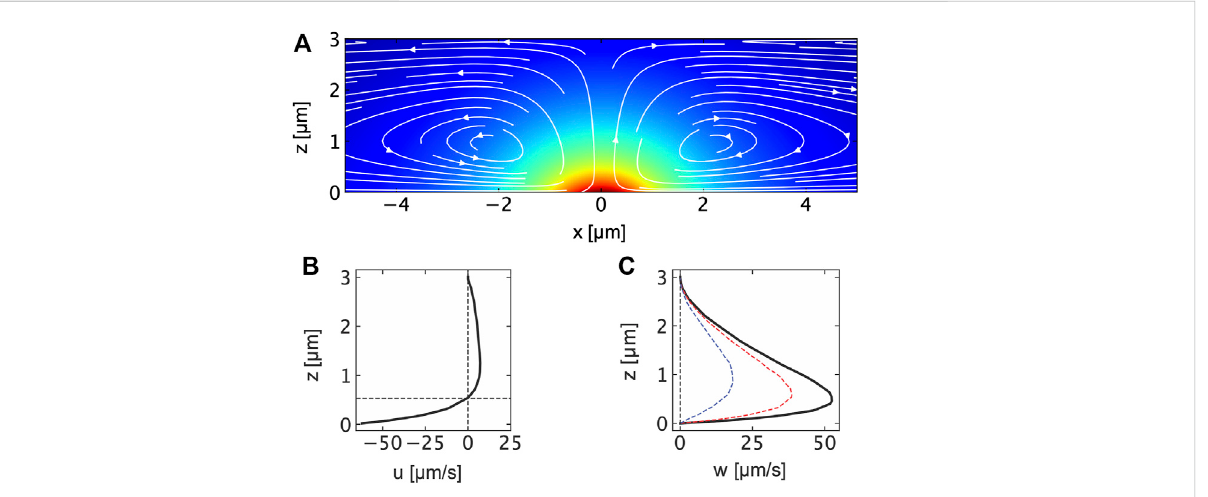
FIGURE 3 (A) Flow fi eld in a thin water fi lm induced by a thermo-osmotic quasi-slip fl ow at a locally heated thin gold fi lm at z = 0 μ m. The fl ow fi eld has been obtained in fi nite element simulations with a Gaussian heat source corresponding to the incident laser beam pro fi le. The maximum temperature at the gold fi lm is found to be Δ T max = 50 K. The fl ow is calculated according to Eq. 1 with the thermo-osmotic coef fi cient of χ = χ Au = 10 · 10 – 10 m 2 s − 1 . The background color indicates the temperature in the fi lm. (B) Horizontal fl ow fi eld component u calcalated at x = 500 nm indicating the strong boundary fl ow for z < 600 nm and the weaker out fl ow for z > 600 nm. (C) Vertical fl ow fi eld component w calculated at x = 0 nm, 500 nm and 1 μ